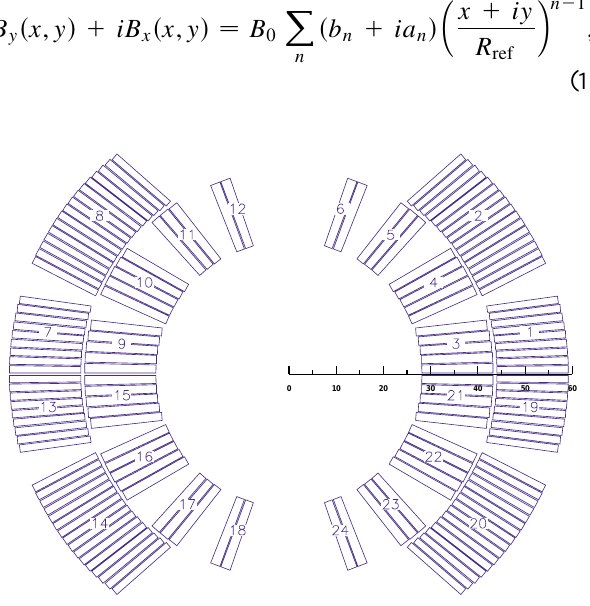
FIG. 1. (Color) Cross section of the six-block LHC dipole coil.